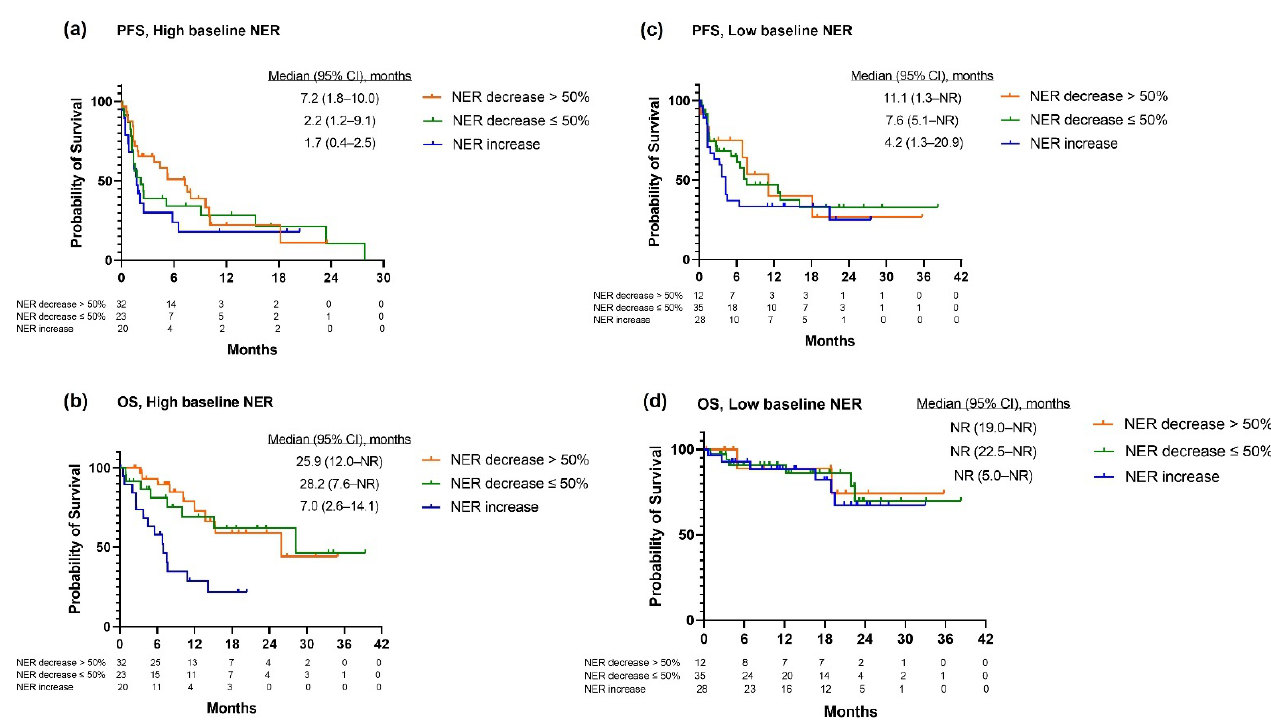
Figure 3. PFS/OS by baseline NER and NER change at week 6.